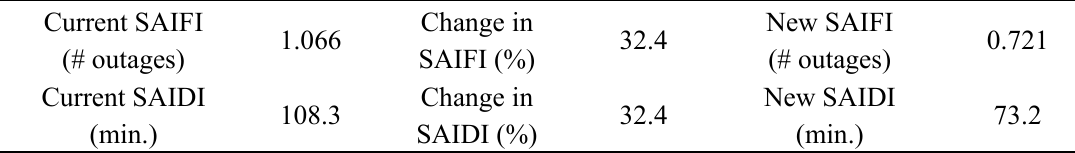
Table 3. Benefits due to less power